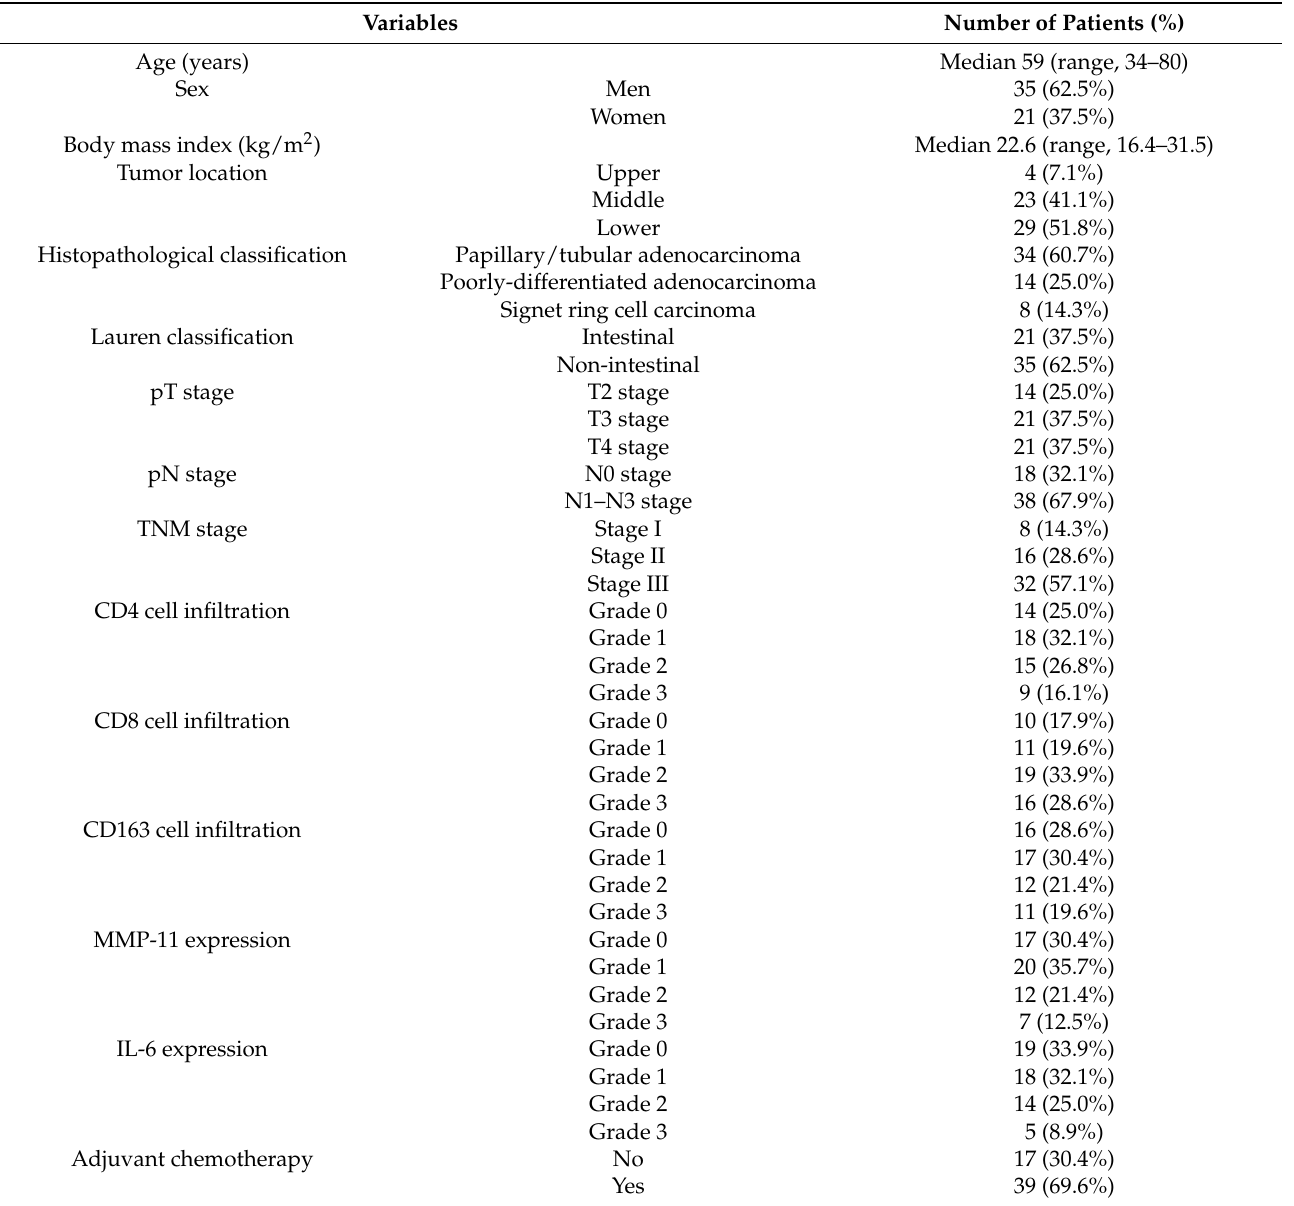
Table 1. Clinical characteristics of the study population ( n =